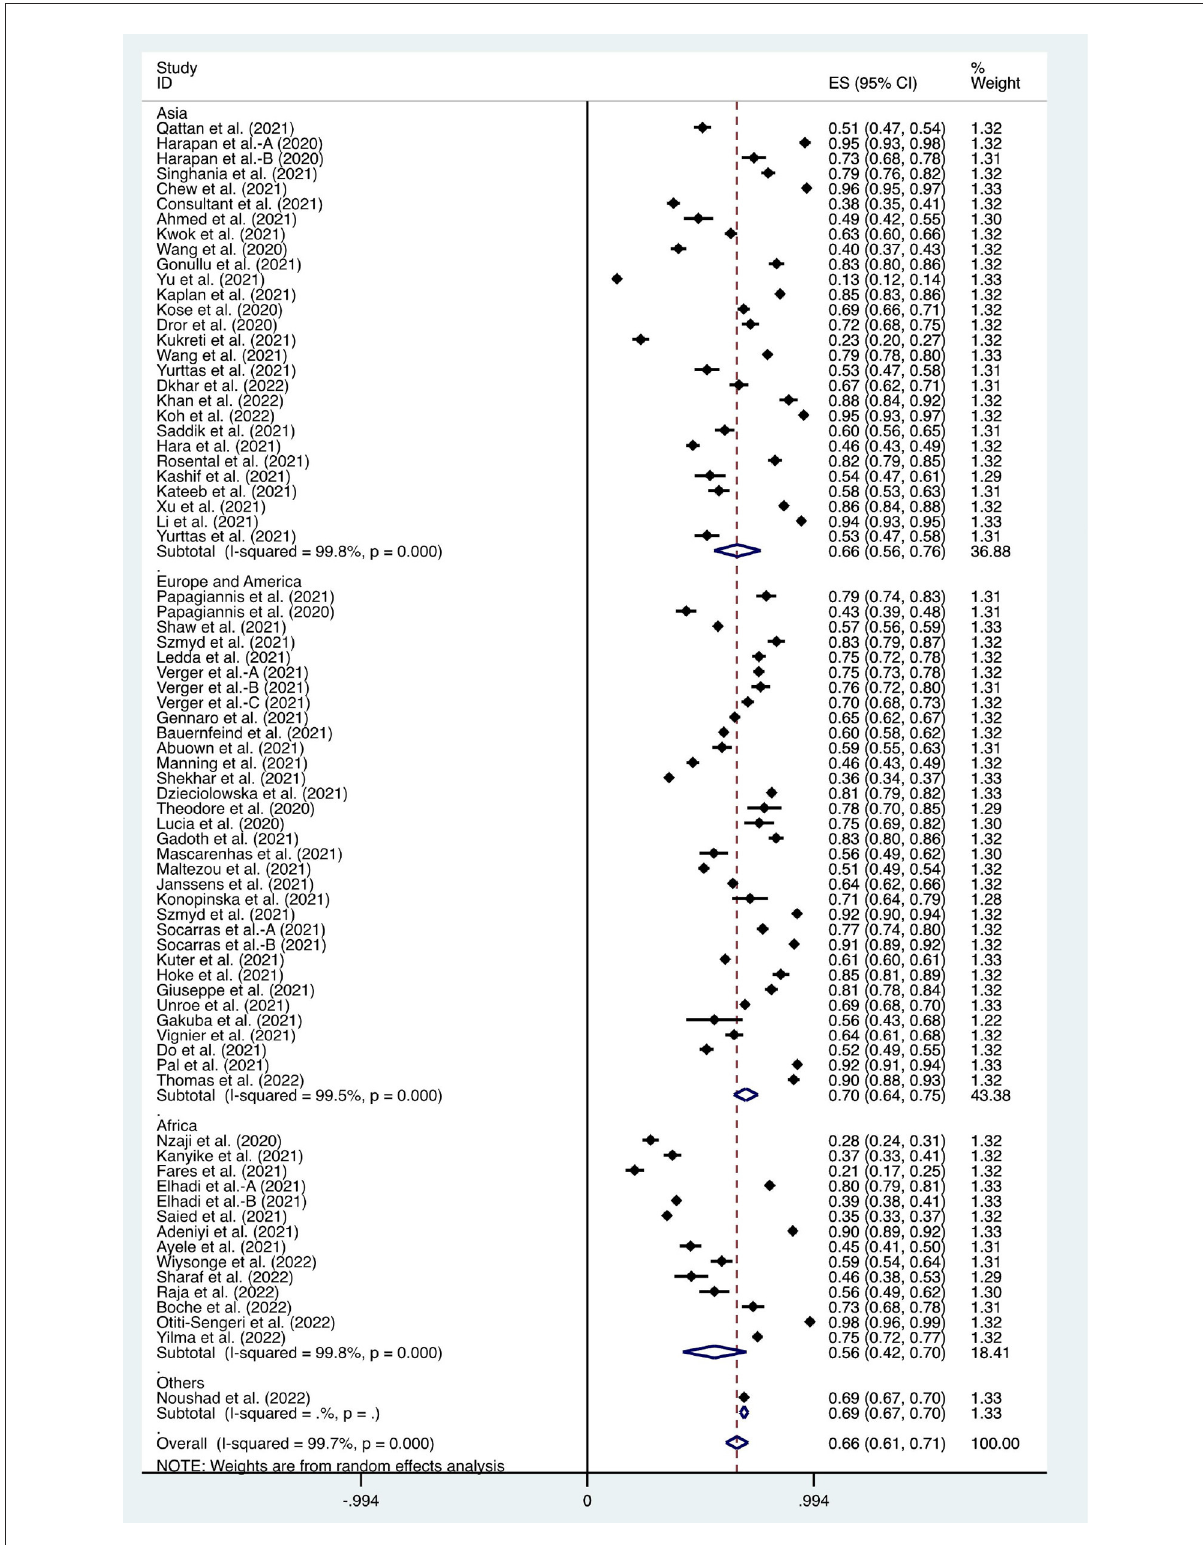
FIGURE2 Forest plot of the acceptance of coronavirus disease 2019 vaccines by healthcare